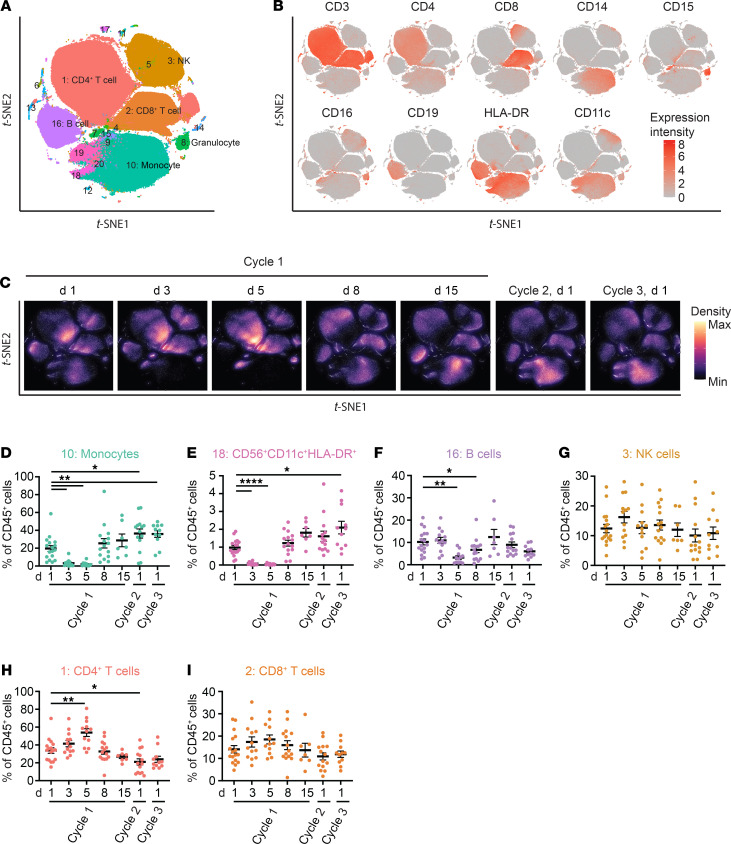
Cellular response to CD40 agonist–based chemoimmunotherapy.(A) After exclusion of doublets and dead cells and positive selection of CD45, samples, including patients and healthy volunteers (HVs), were downsampled to 5000 events and concatenated and FlowSOM clustering analysis was performed. (B) Marker expression level plots. (C) Density plots. (D–I) Quantification of cluster frequency. Mean ± SEM is shown. Day 1, n = 17; day 3, n = 13; day 5, n = 12; day 8, n = 15, day 15, n = 7, cycle 2, n = 14, cycle 3, n = 11. Mixed effects analysis with Dunnett’s multiple-comparison test was performed. *P < 0.05; **P < 0.01; ****P < 0.0001.